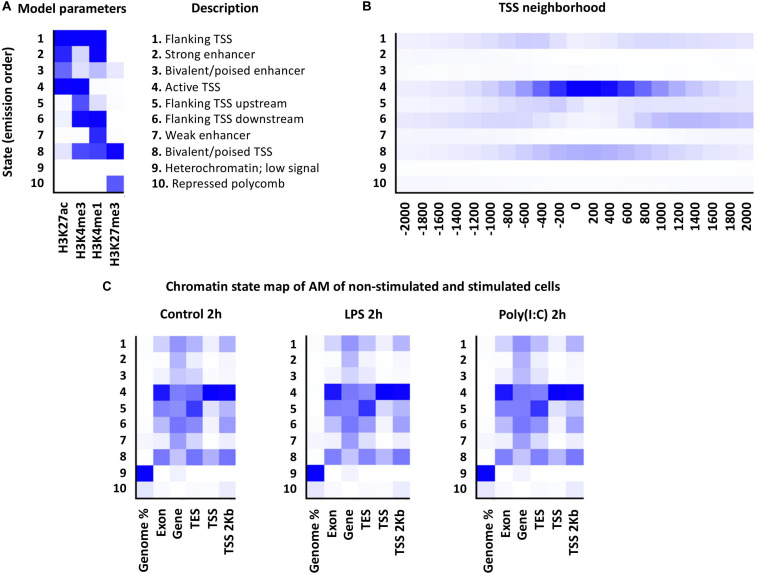
Chromatin states of porcine alveolar macrophages. (A) At left is shown a heatmap of the emission parameters, each row corresponds to a different state, and column for each histone mark. The darker blue color corresponds to a greater probability of observing the histone mark. At right is shown the description of the specific chromatin state (B) The TSS neighborhood heatmap shows the overlap enrichment for each state for each 200-bp bin within 2 kb around a set of TSSs. (C) Heatmap showing the emission parameters of non-stimulated and stimulated alveolar macrophages with LPS or Poly (I:C) at 2 h. The heatmap displays the overlap enrichment of the histone mark on the current pig genome annotation.